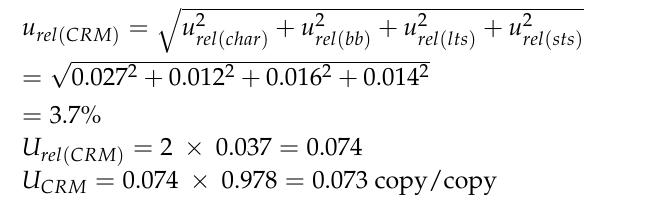
Table S2: DNA quality extracted with different isolation kits. Table S3: Homozygote test result with ddPCR. Table S4: Results of the g10evo-epsps homogeneity test (exogenous/endogenous copy number ratio). Table S5: Results of certified value in eight laboratories. Figure S1. T-DNA structure and insertion site of the ZUTS-33 soybean. Figure S2. ZUTS-33 soybean event-specific real-time PCR amplification